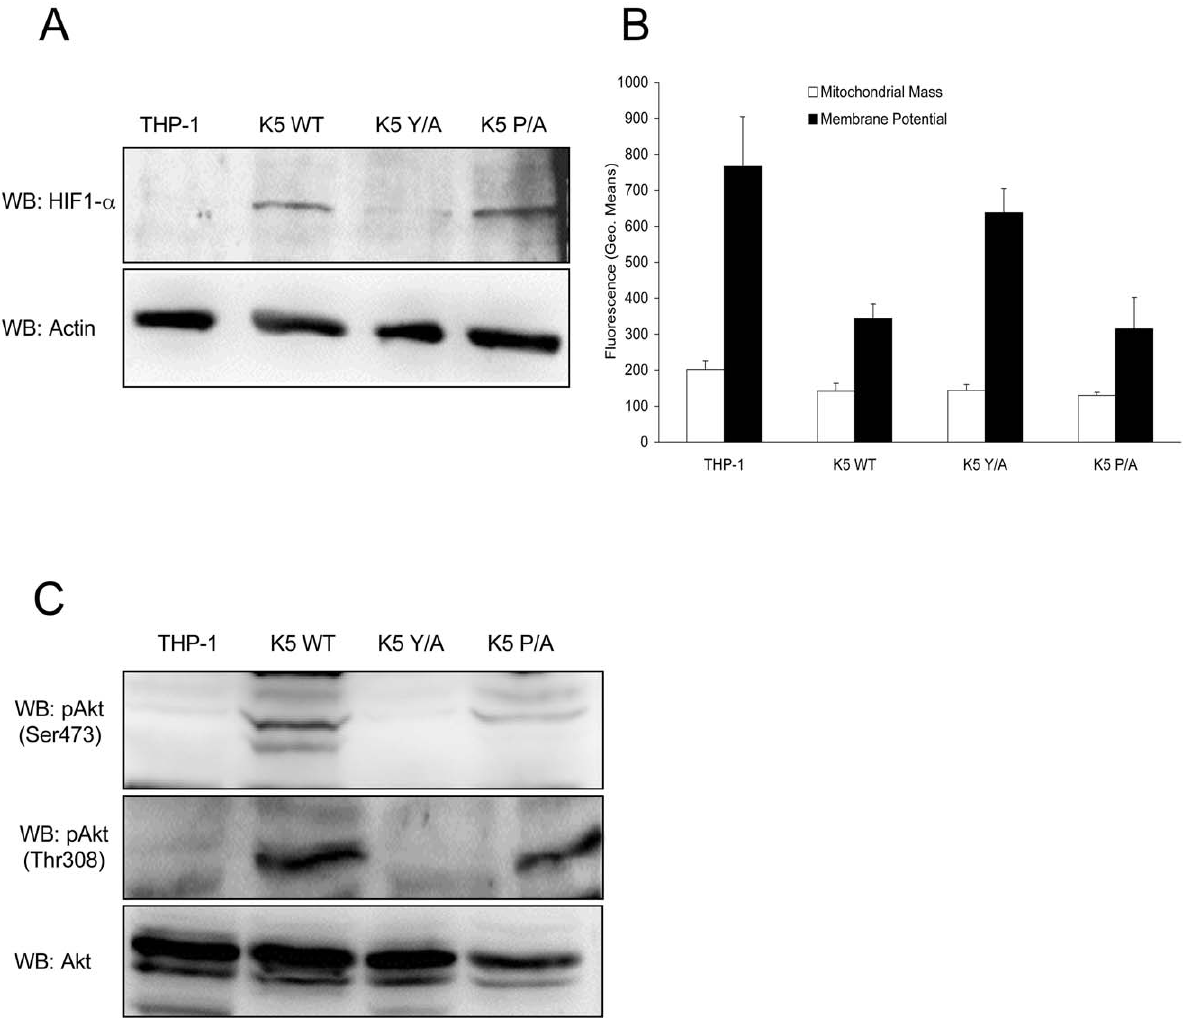
Figure 3. K5 expressing cells have other features of the Warburg Effect. ( A ) Normalized whole cell lysate of each of the indicated THP-1 cell lines were subject to western blot (WB) using an anti-HIF-1 a antibody (top panel) and re-probed with anti-ß-actin antibodies (bottom panel). ( B ) Equal numbers of the indicated cell lines were stained with mitotracker green (Mitochondrial Mass) or mitotracker red (Membrane Potential) and subjected to flow cytometric analysis. ( C ) Normalized whole cell lysates were subjected to western blot (WB) using anti-phospho-Akt (Ser473) (top panel), anti-phospho-Akt (Thr308) (middle panel) or total Akt (bottom panel) antibodies. Data for all panels are representative of three independent